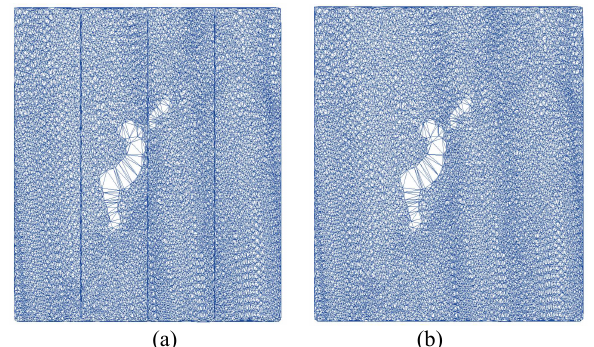
Figure 6. Delaunay triangulation construction of a relatively large size of point cloud in the experimental area: (a) The four initially merged triangular networks; (b) The final optimized Delaunay triangular network from (a).